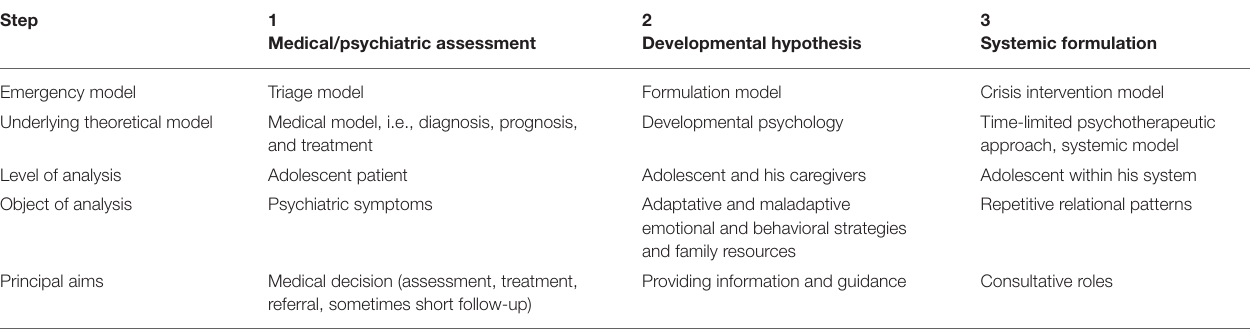
TABLE 2 | Hypothetical case vignettes synthesized from several real cases of adolescents referred to PED for aggressive